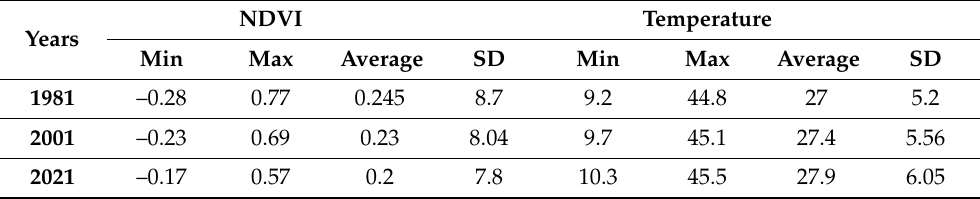
Figure 6. NDVI maps for the years ( a ) 1981, ( b ) 2001, and ( c ) 2021 of the Sahiwal District. Table 8. Maximum and minimum temperature and NDVI values for the year from 1981 to 2021.